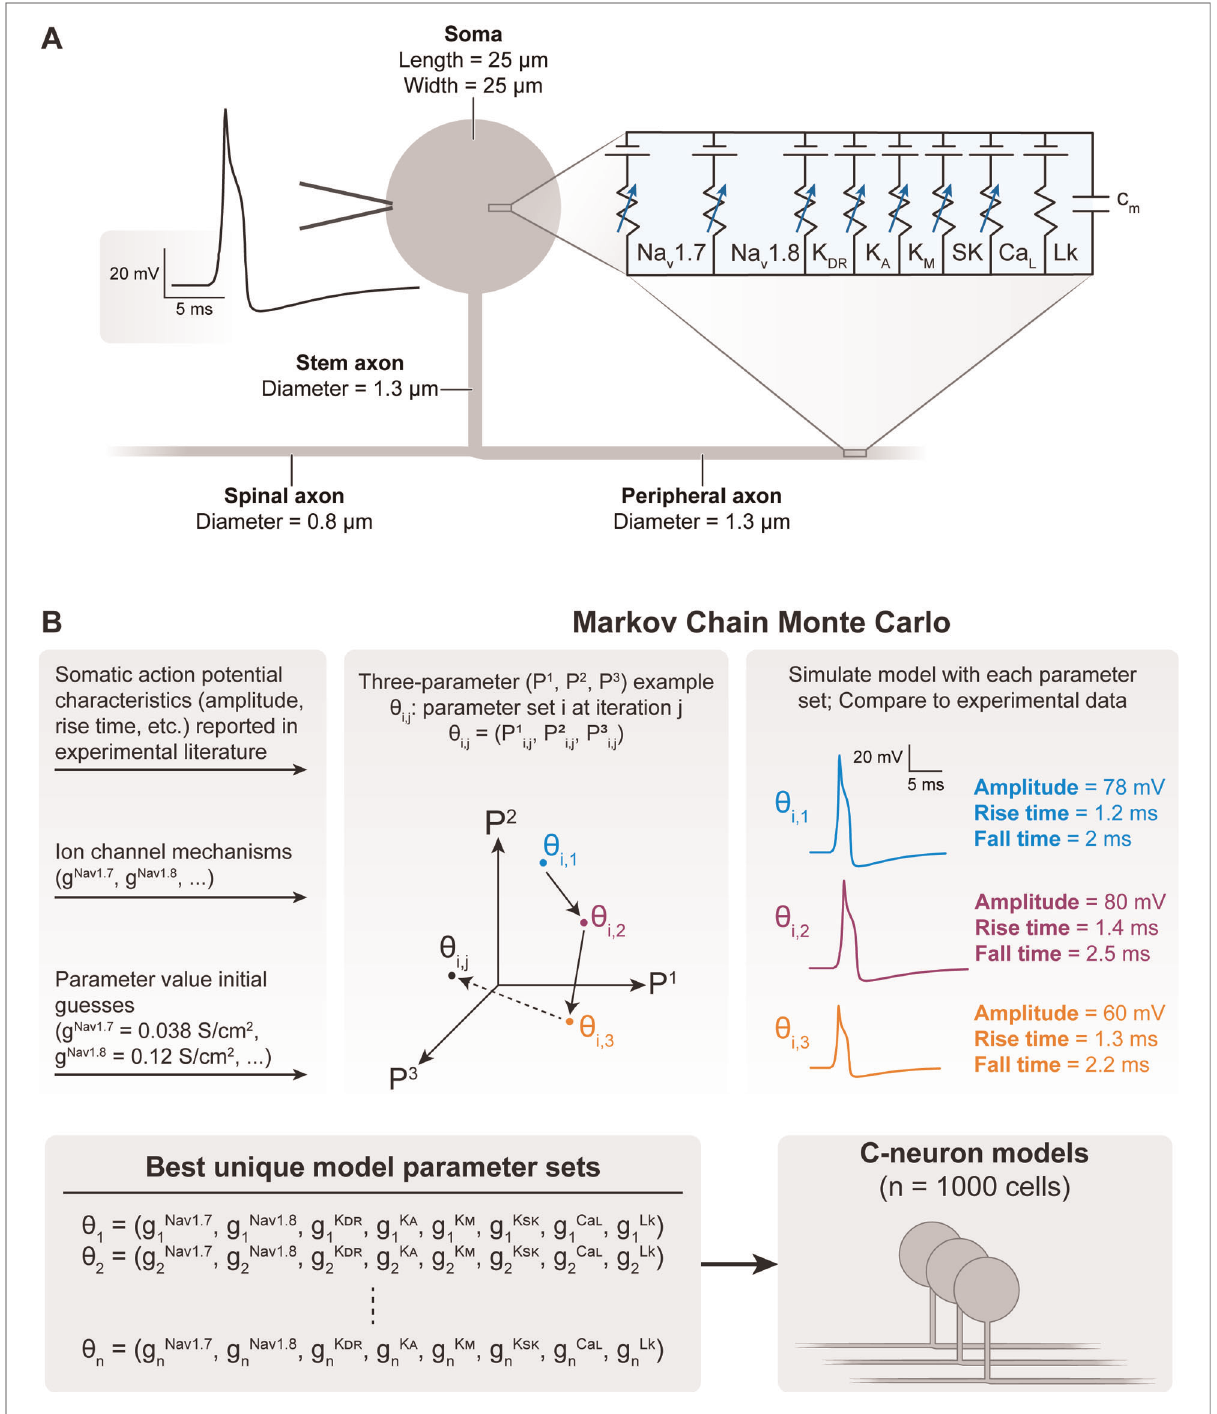
FIGURE 2 Construction and parametrization of a population of biophysically distinct multi-compartment model C-neurons. ( A ) We implemented a modi fi ed version of our previously published multi-compartment C-neuron model (11, 12). A representative action potential (AP) is shown on the left, and the included active ion channels are shown in the circuit schematic on the right. ( B ) We implemented a Markov Chain Monte Carlo (MCMC) method to parametrize a population of model C-neurons with different combinations of maximal ion channel conductances (41). A three- parameter (P1 – P3) example is shown for visualization purposes. Our implementation of the MCMC method simulated thousands of possible parameter combinations (i.e., gNav1.7, gNav1.8, gKDR, gKA, gKM, gKSK, gCaL, gLk) in the model C-neuron and compares the resulting AP characteristics to those published in experimental literature. The result of the MCMC method was a population of the one thousand “ best ” parameter combinations which we could simulate in our model C-neuron during